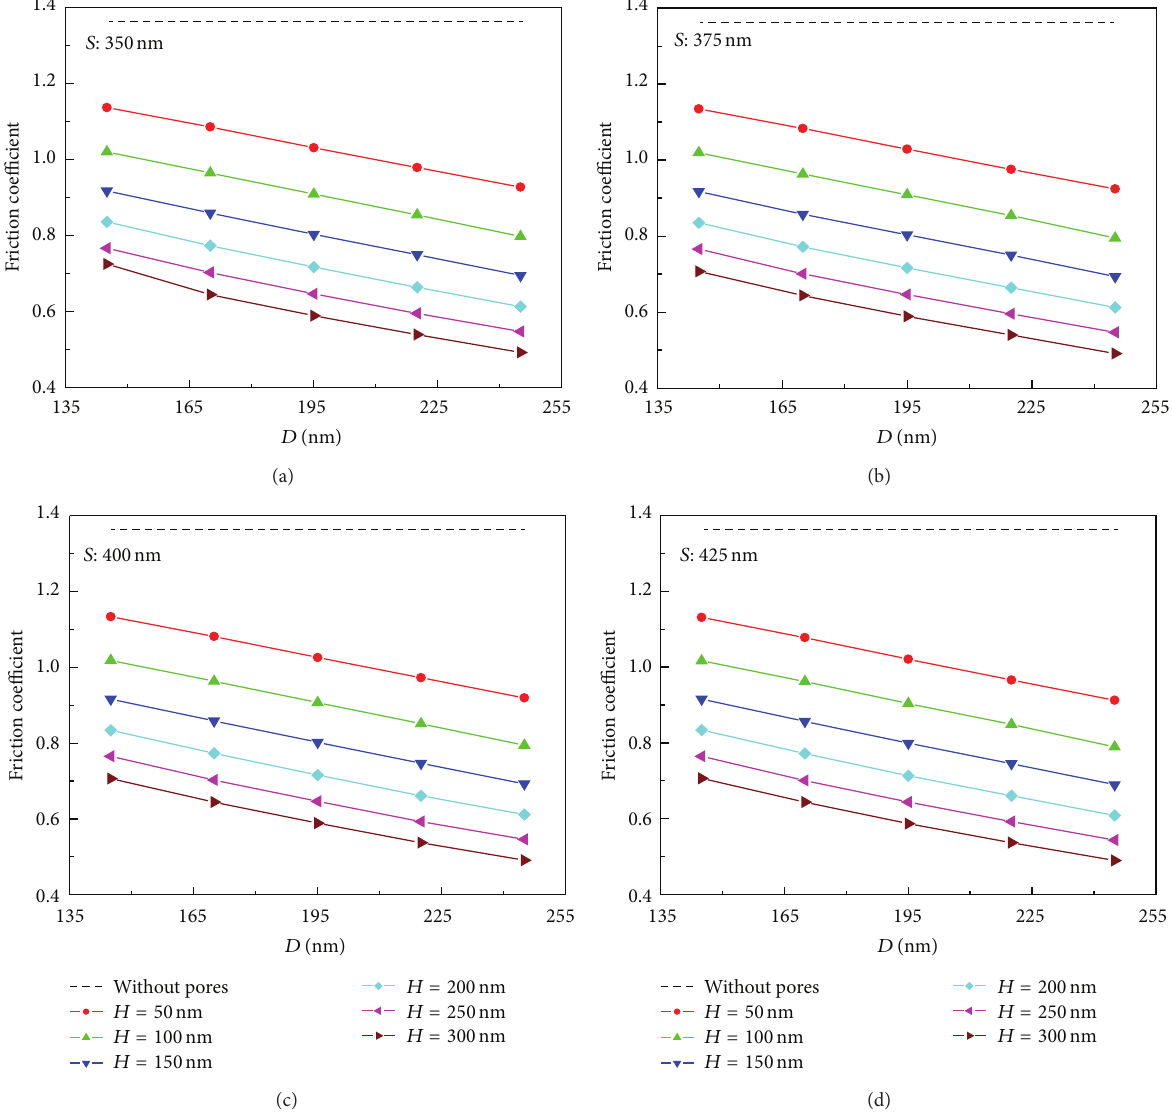
Figure 6: Friction coefficient at different pore diameters and depths of Coscinodiscus sp.: (a) at interval of 350 nm, (b) at interval of 375 nm, (c) at interval of 400 nm, and (d) at interval of 425